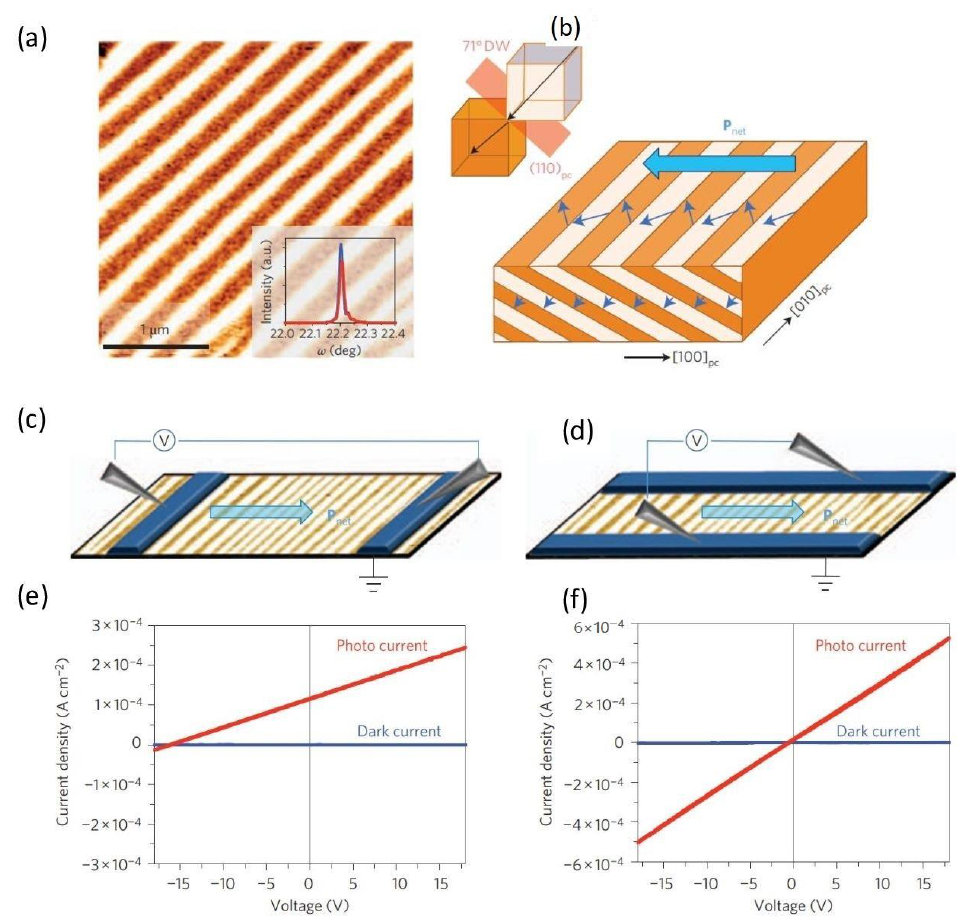
Figure 9. ( a ) Walls periodic arrays PFM image (71 ◦ domain). ( b ) Schematic of the X-ray rocking curves along two orthogonal crystal axes are shown in the inset. Arrows indicate the ferroelectric polarization of different components. Representative illustrations of domain walls parallel ( c ) at ( d ) at right angles. The responsive measured I–V curves are perpendicular to the domain walls ( e ) and parallel to the domain walls ( f ). Reproduced with permission from Ref.